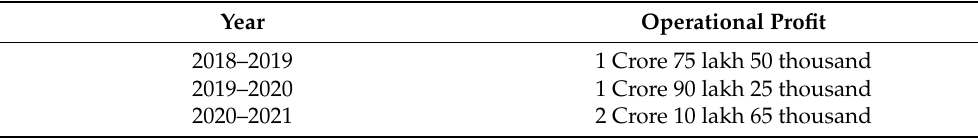
Table 6. Amount of Operational Profit of the corporation over last three years (In Crores). Year Operational